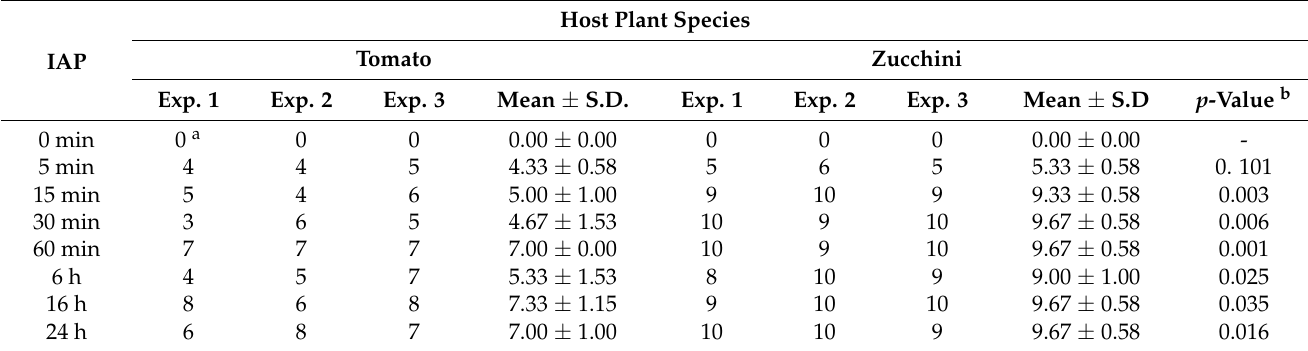
Table 2. Inoculation feeding period of the transmission of ToLCNDV by B.